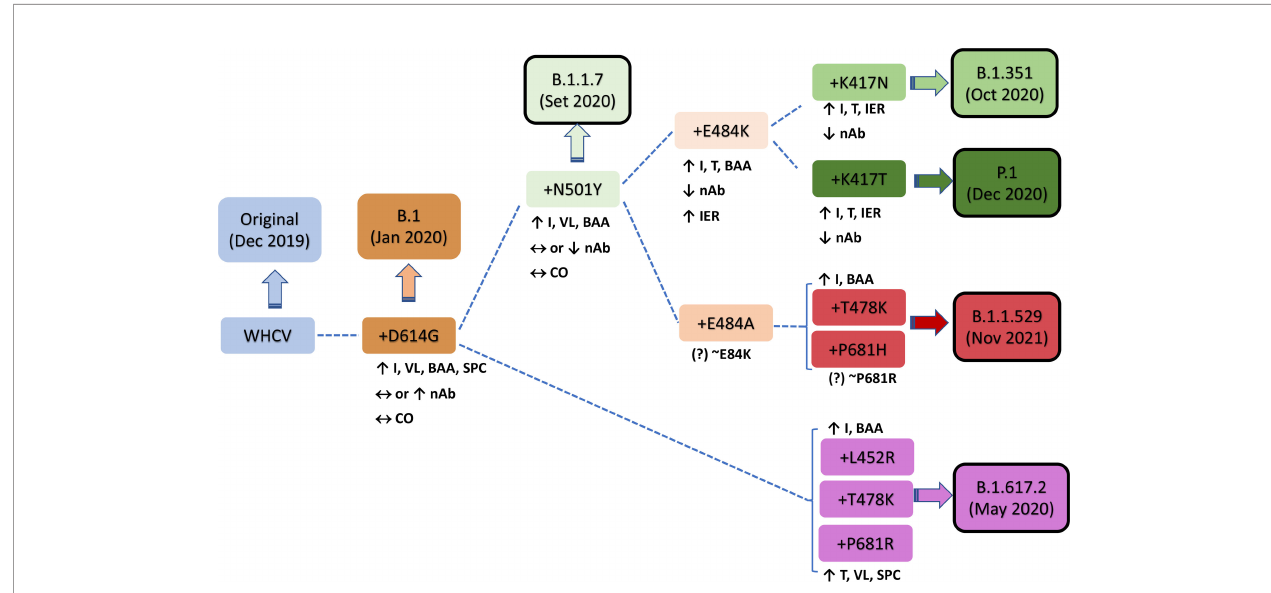
FIGURE 2 | Characteristics of key mutations in variants of concern (VOCs). A comparison was performed versus the original virus (WHCV) or the B.1 strain (+D614G). BAA, binding af fi nity to ACE2; CO, clinical outcome; I, infectivity; IER, immune evasion risk; nAb, neutralizing antibody; SPC, spike protein cleavage; T, transmissibility; VL, viral load; WHCV, WH-Human 1